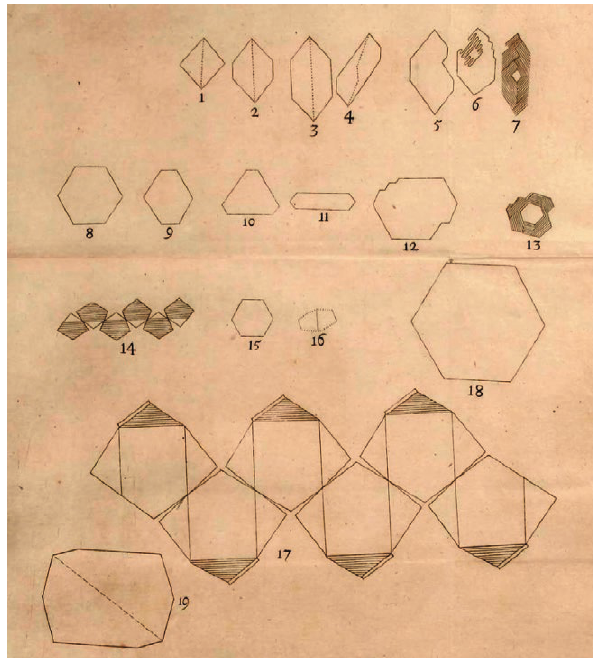
Fig. 12. Detail of plate published in Steno’s Prodromus